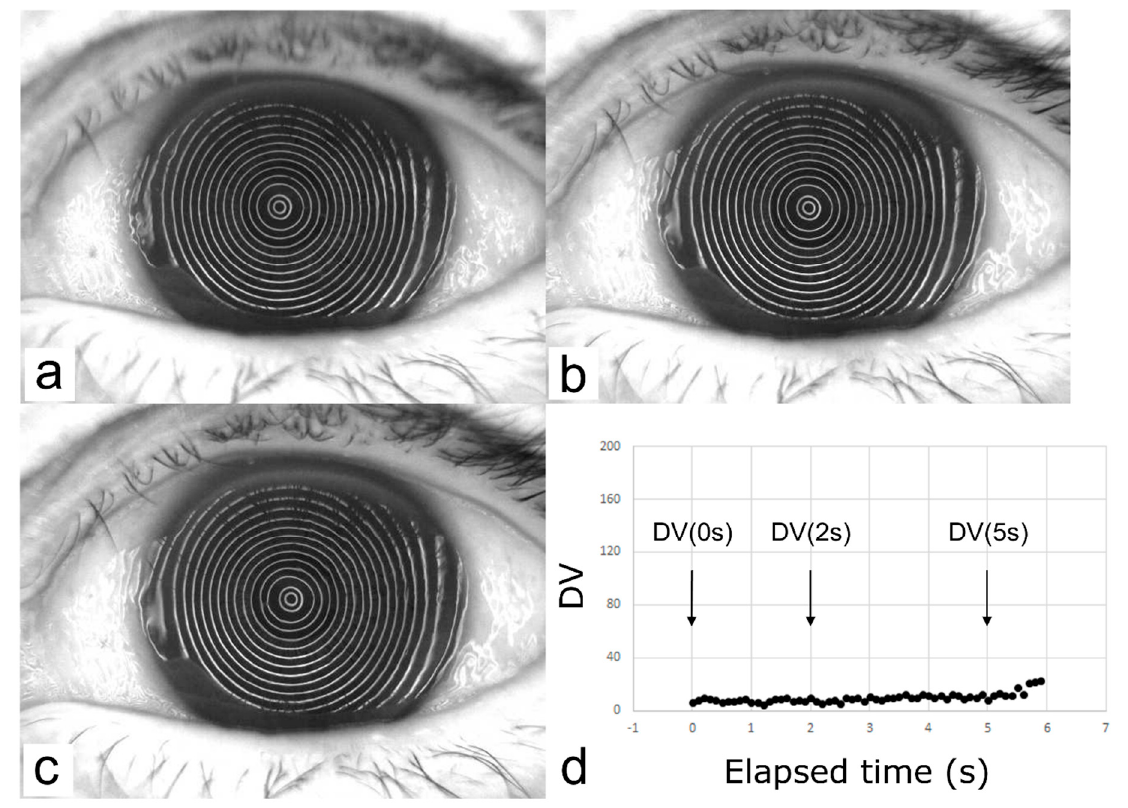
Figure 5. A representative case in the Random Break (RB) group (the left eye of an 81-year-old female). No MR distortion was seen at any area of the cornea or in any images (( a ), immediately after eye opening; ( b , c ), 2 s and 5 s after keeping the eye open, respectively) that are reflected on the graph; thus showing almost constant DV over time ( d ).